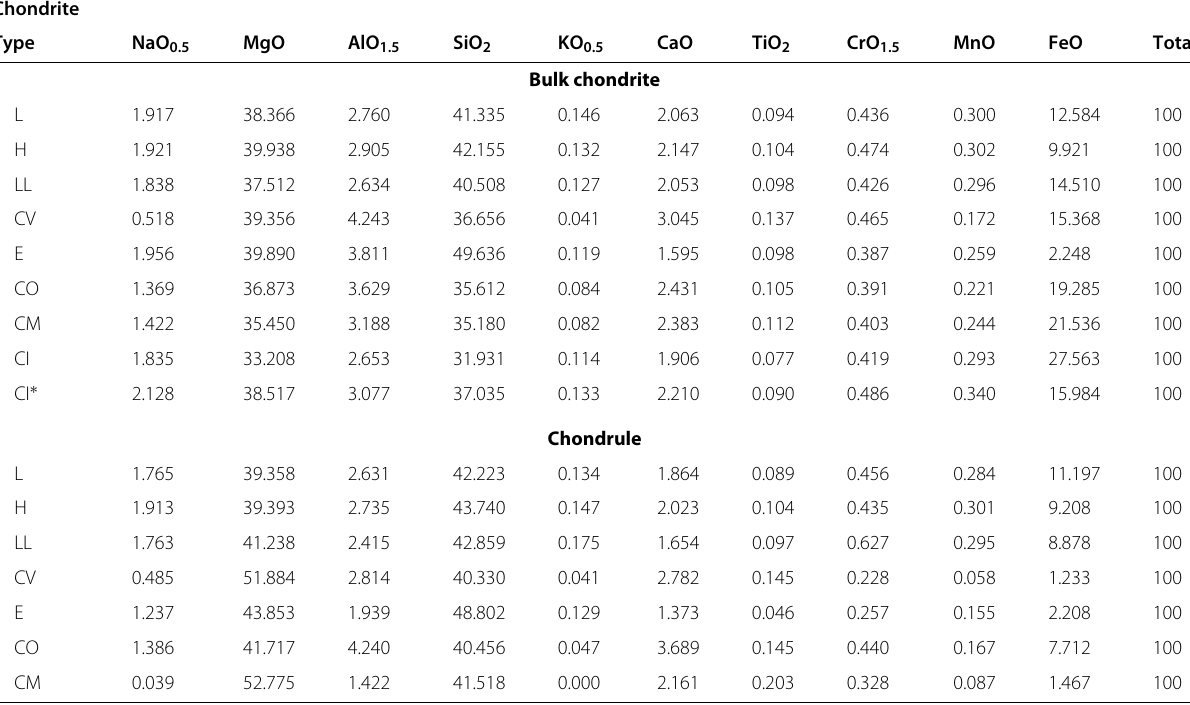
Table 1 Bulk (silicate) chemical compositions of chondrites and average chemical compositions of chondrules (mol%) Chondrite